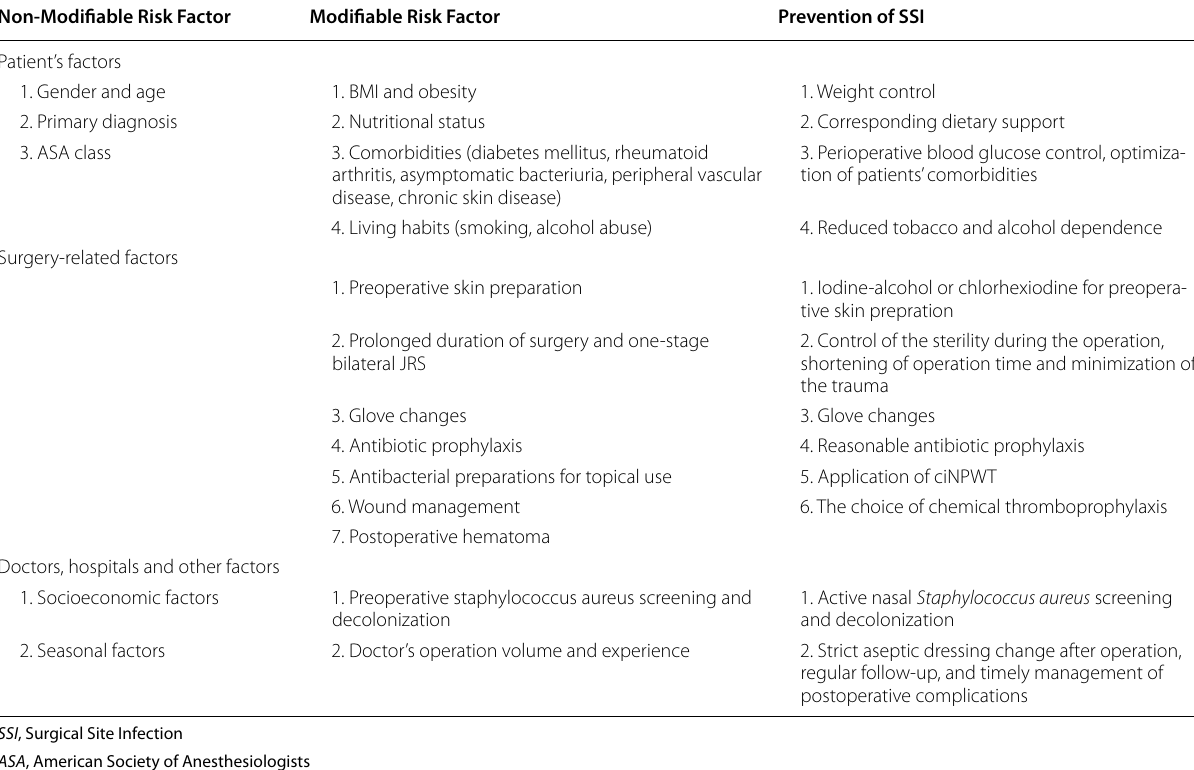
Table 1 A summary of risk factors associated with post-JRS